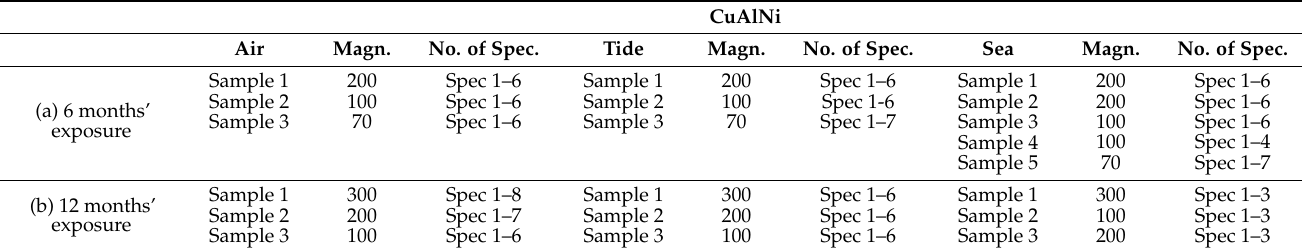
Table 4. The number of samples and spectrums for: ( a ) The CuAlNi alloys in the sea, tidal zone, and atmosphere after 6 months’ exposure, ( b ) the CuAlNi alloys in the sea, tidal zone, and atmosphere after 12 months’ exposure. CuAlNi Air Magn. No. of Spec. Tide Magn. No. of Spec. Sea Magn. No. of Spec.